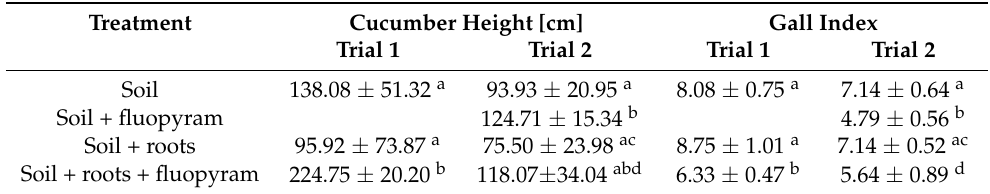
Table 2. Effect of planting hole treatment with fluopyram on cucumber root galling and plant growth in Meloidogyne incognita -infected greenhouse soil, where M. incognita -infected root systems of previous crops were kept or